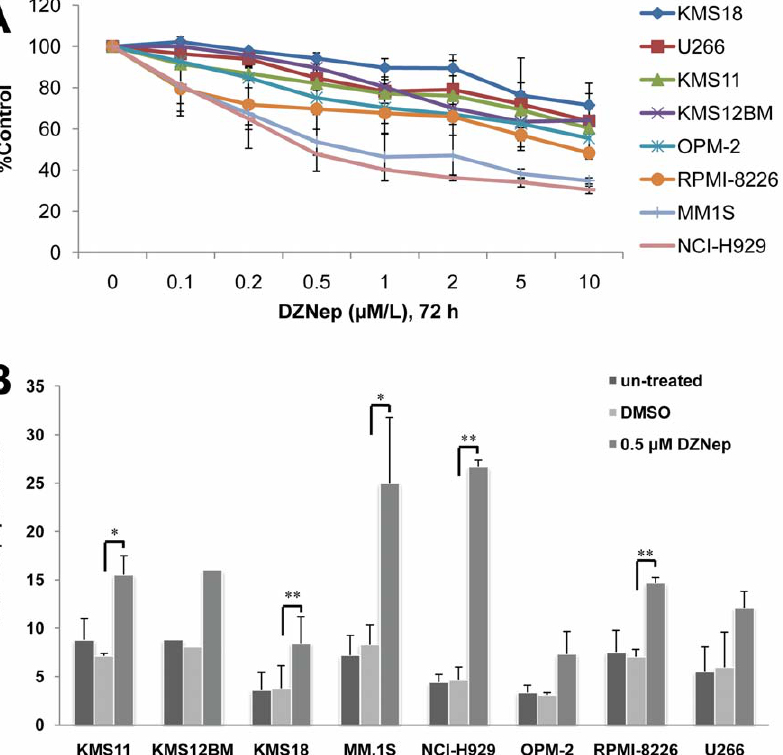
Figure 1. MM cell lines display differing degrees of sensitivity to DZNep. (A) Cells were treated with various concentrations of DZNep for 72 h. The proliferation was determined by MTS colorimetric assay (Promega). Data represent the mean 6 SD derived from 3 separate experiments with triplicate wells per condition. (B) Cells were treated with 0.5 m M DZNep for 72 h, and apoptosis was measured by flow cytometric sub-G1 analysis. Data represent the mean 6 SD derived from 3 separate experiments (one time for KMS12BM). * indicates p , 0.05, and ** indicates p ,